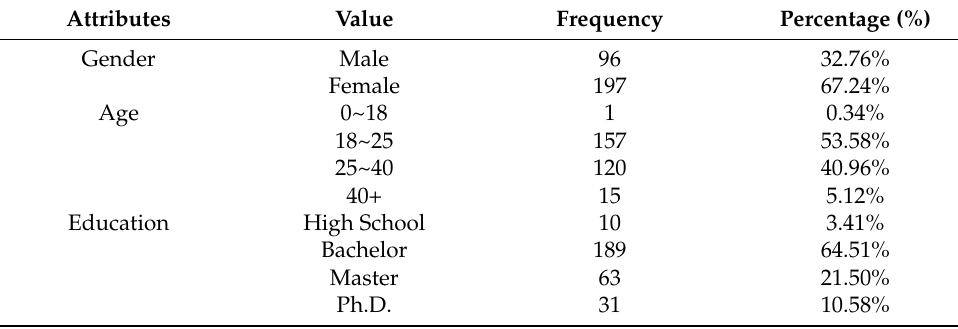
Table A1. Demographic information for the